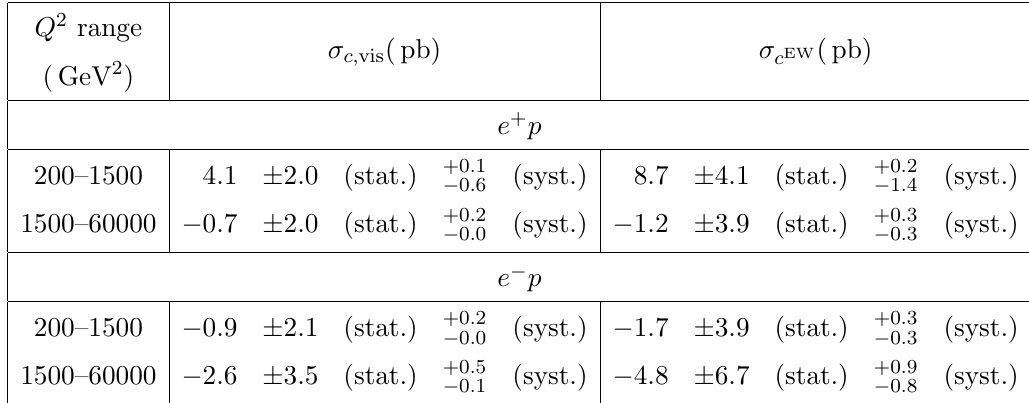
Table 2. Measured visible cross sections, (cid:27) c; vis , and EW cross section, (cid:27)